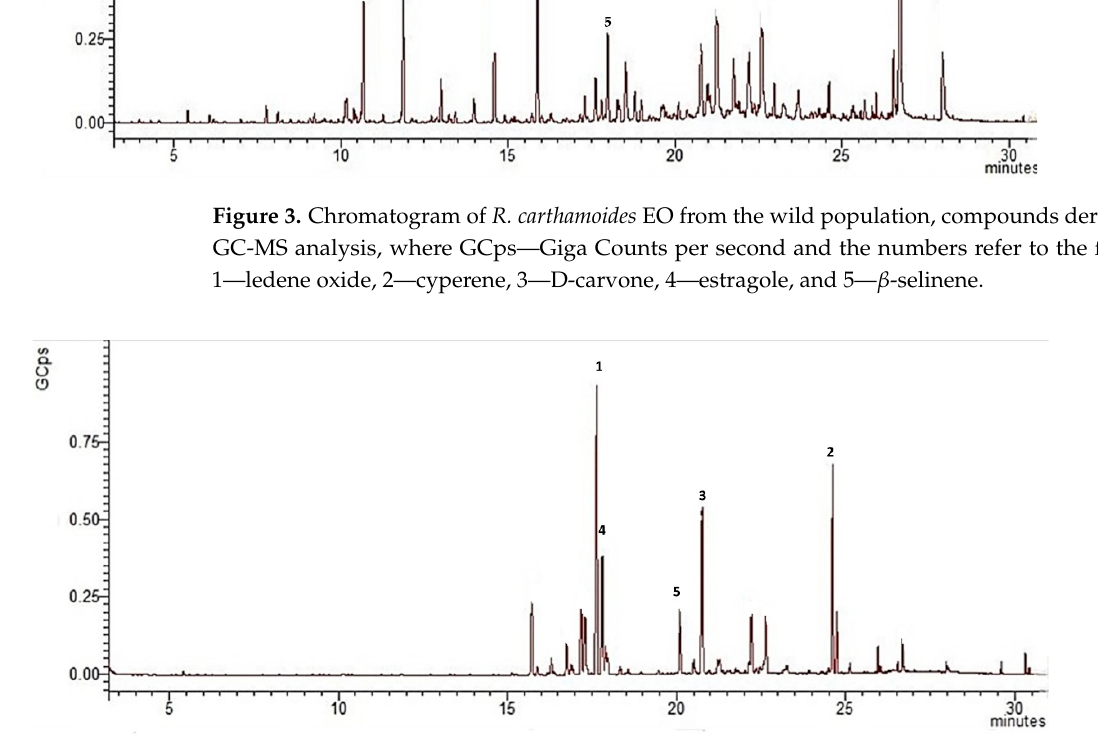
Figure 4. Chromatogram of R. carthamoides EO cultivated in Bulgaria, compounds derived from GC-MS analysis, where GCps—Giga Counts per second and the numbers refer to the